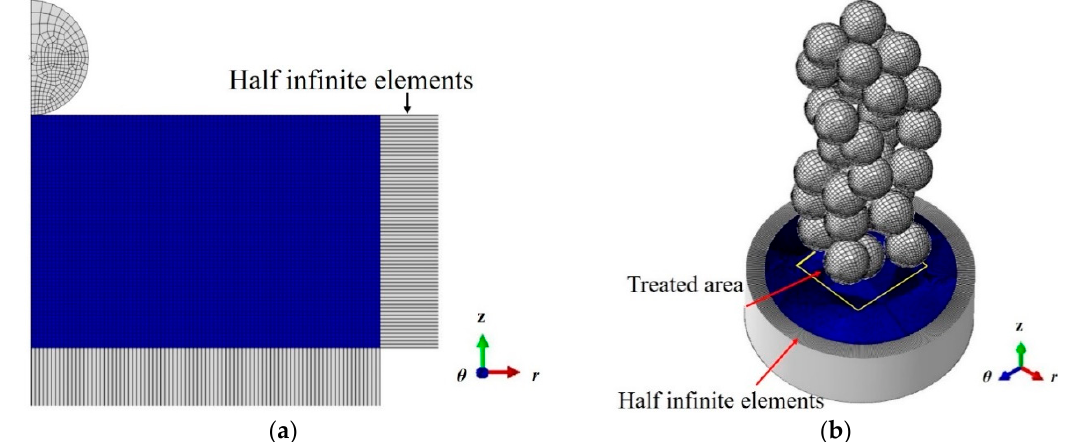
Figure 3. ( a ) Single shot model; ( b ) 3D random multiple shots model.